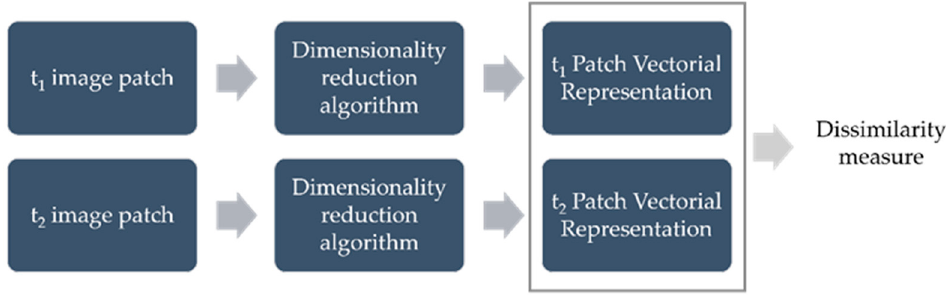
Figure 10. Scheme of the change detection.